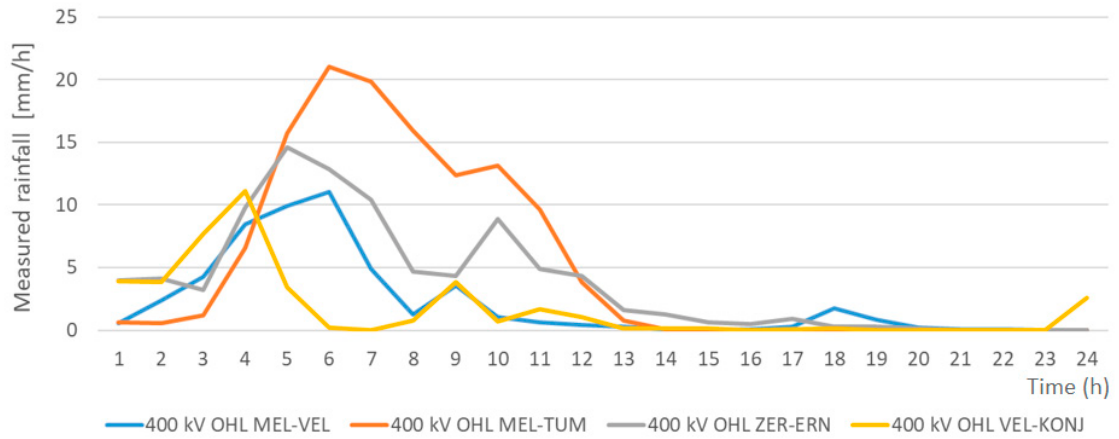
Figure 19. Measured rainfall for each 400 kV OHL on the selected day—20 May 2020.